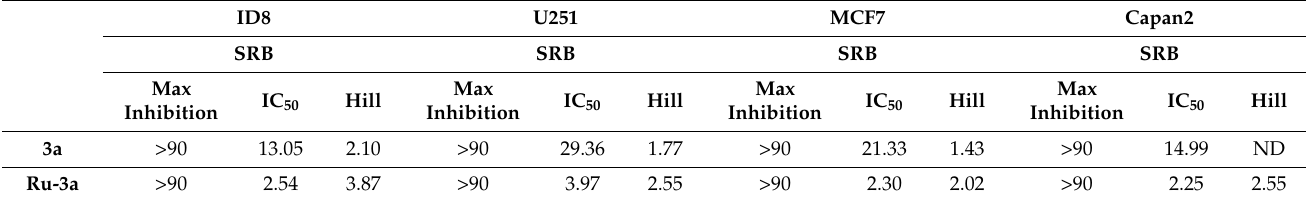
Table 7. The kinetic values of compounds 3a and Ru-3a in cancer cell lines other than A2780.